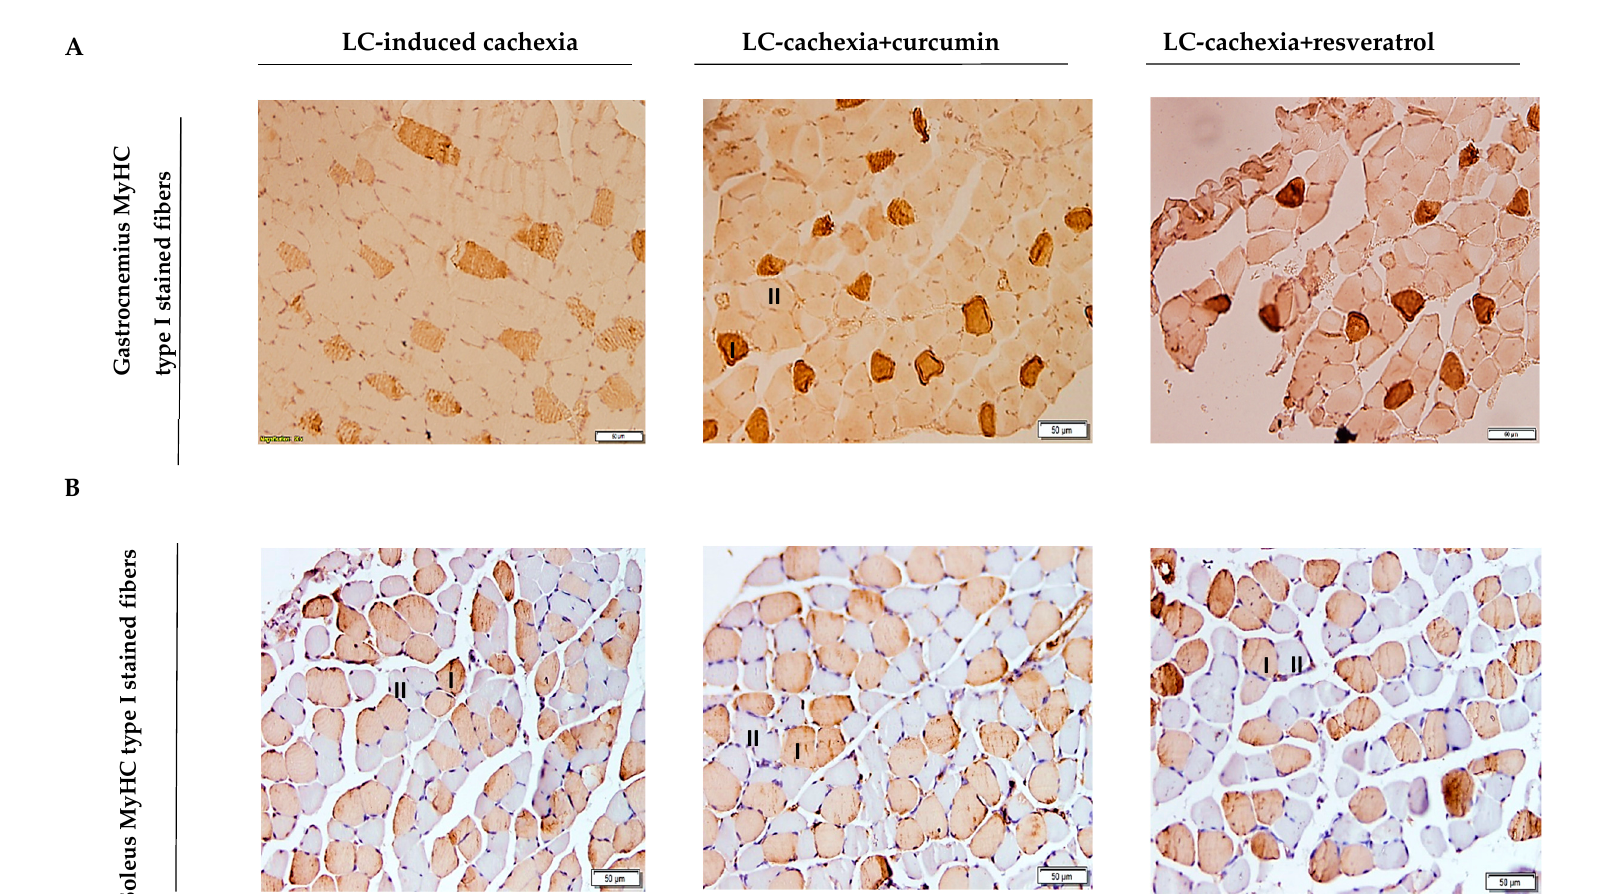
Figure 2. ( A ) Representative images of muscle fibers ( × 200) of gastrocnemius ( A ) and soleus ( B ) muscle of all study groups of mice. Slow-twitch fibers (I symbol within the fibers) were positively stained with the corresponding antibody (brown color), while the nonstained fibers were fast-twitch ones (II symbol within the fibers).